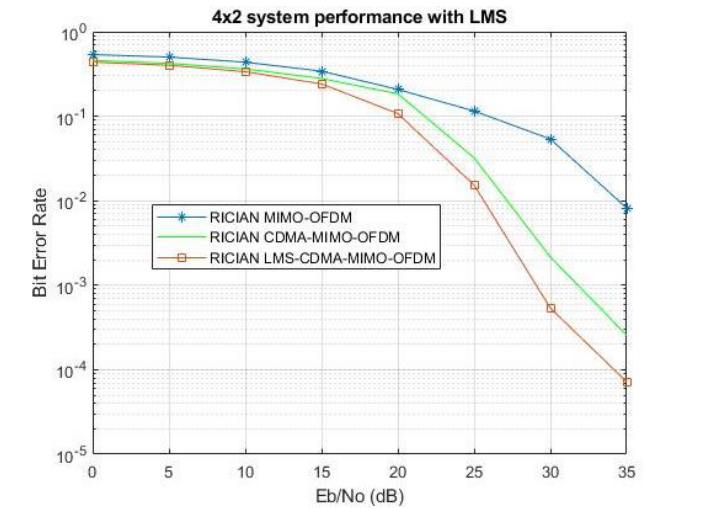
Figure 18. SNR vs. BER plot for 4×2 LMS-MIMO-OFDM model in Rician channel.